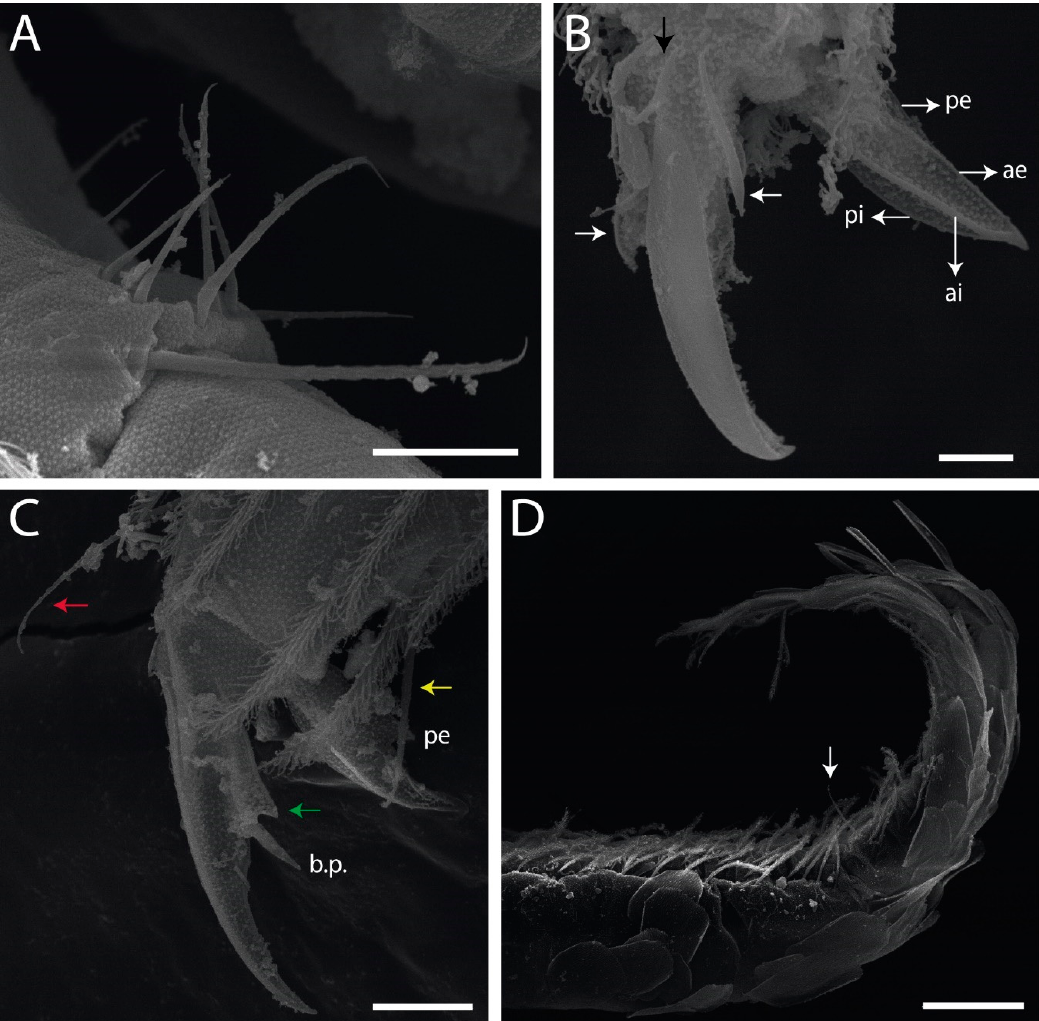
Figure 5. Pseudosinella spp.: SEM of trunk appendages. ( A ) trochanteral organ (inner side); ( B ) empodial complex II (anterior side); white arrows on unguis outer side indicate paired hook-shaped teeth; black arrow indicates unpaired median tooth; and ae, ai, pi, and pe are unguiculus lamellae; ( C ) distal tibiotarsus and empodial complex III (anterior side); red arrow indicates tenent hair on tibiotarsus outer side, yellow indicates smooth chaeta on tibiotarsus inner side; green indicates paired hook-shaped teeth; b.p. is posterior basal tooth; and pe is unguiculus lamella; ( D ) furcula (lateral view): arrow indicates smooth chaetae on proximal dens. Scale bars: 0.005 mm ( A , C ), 0.002 mm ( B ), and 0.02 mm ( D ).